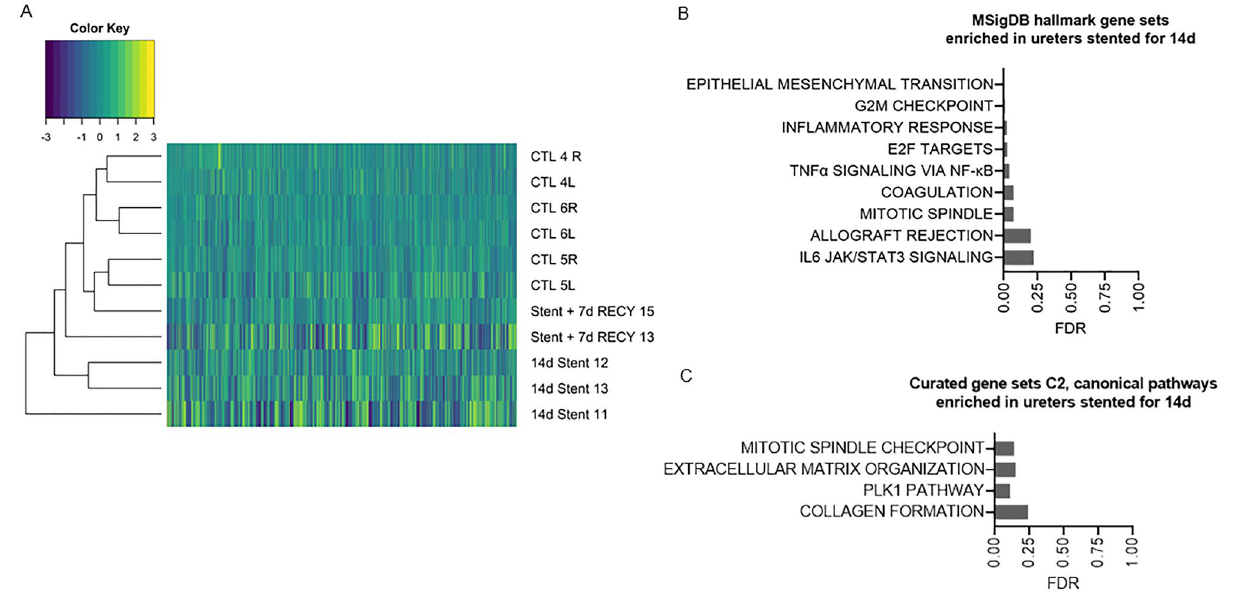
Figure 4. ( A ) Heatmap of gene expression of ureters stented for 14 days (14d Stent), stented for 14 days followed by 7 days of recovery (Stent + 7d RECY) and control ureters (CTL). Genes with more than 5 or more missing values were deleted (n = 10,937) ( B ) Top 9 mSIGDB Hallmark Gene Sets enriched in 14 d stented ureters with an FDR < 0.25 and p < 0.05. ( C ) Top 4 Curated gene sets canonical pathways (C2CP) enriched in 14 days stented ureters with an FDR Curated an FDR < 0.25 and p <